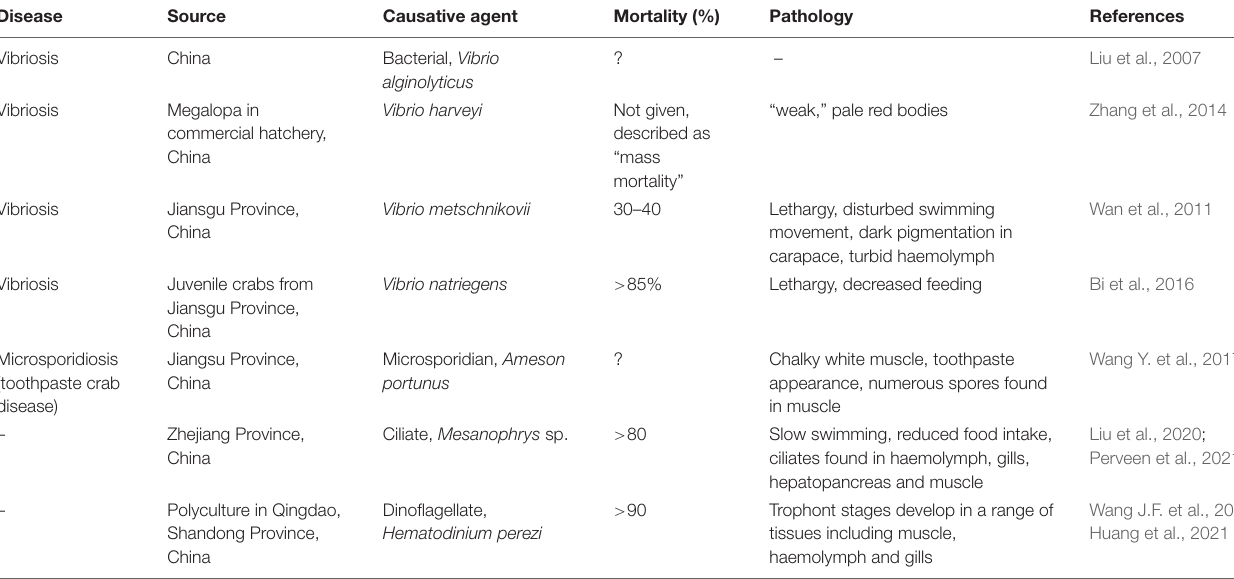
TABLE 3 | Key diseases of Portunus trituberculatus in